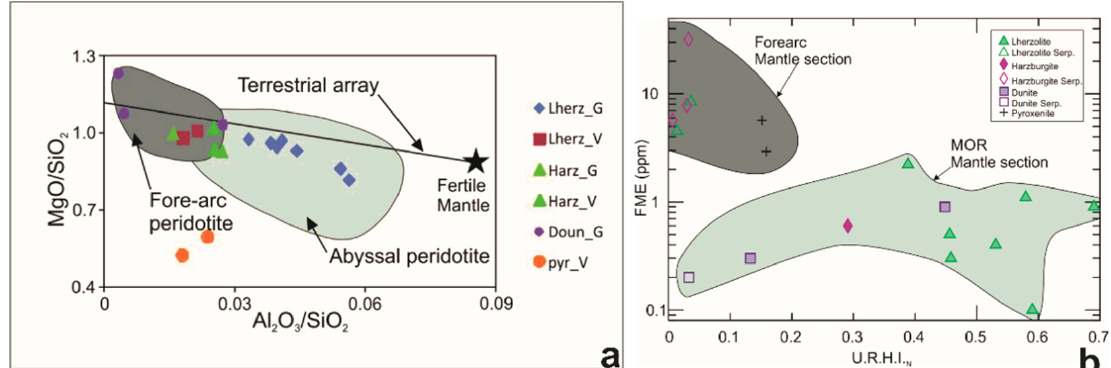
Figure 9. ( a ) Al 2 O 3 /SiO 2 vs. MgO/SiO 2 diagram of peridotites from the Veria–Naousa and Gerania ophiolite complexes (fields after: [94]); ( b ) Correlation diagram of Fluid Mobile Elements (FME: Pb, As, Sb, Th, U, Sr) versus the normalized Ultramafic Rock Health Index (U.R.H.I. N ). The field of ultramafics hosted within a forearc mantle section (Veria–Naousa ophiolite) consists of samples with elevated FME concentrations coupled with low U.R.H.I. N , whereas the MOR field consists of samples with variable U.R.H.I. N and low FME concentrations (Gerania ophiolite).